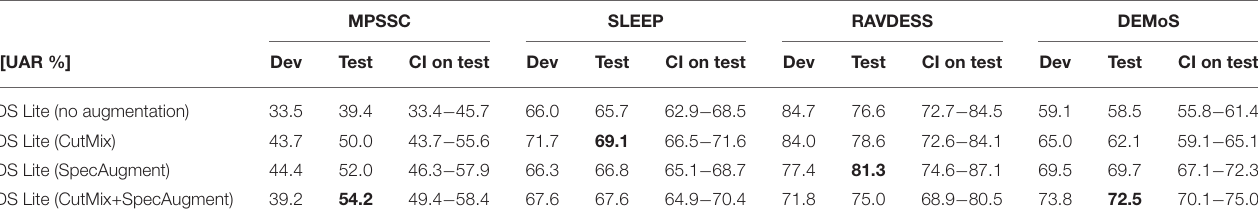
TABLE 4 | Results of the transfer learning experiments with DeepSpectrumLite (DS Lite) on four datasets, the ComParE 2018 Snore Sub-Challenge tasks Snore, the ComParE 2019 Continuous Sleepiness Sub-Challenge SLEEP, RAVDESS emotional song and DEMoS. MPSSC SLEEP RAVDESS DEMoS [UAR %] Dev Test CI on test Dev Test CI on test Dev Test CI on test Dev Test CI on test DS Lite (no augmentation) 33.5 DS Lite (SpecAugment)